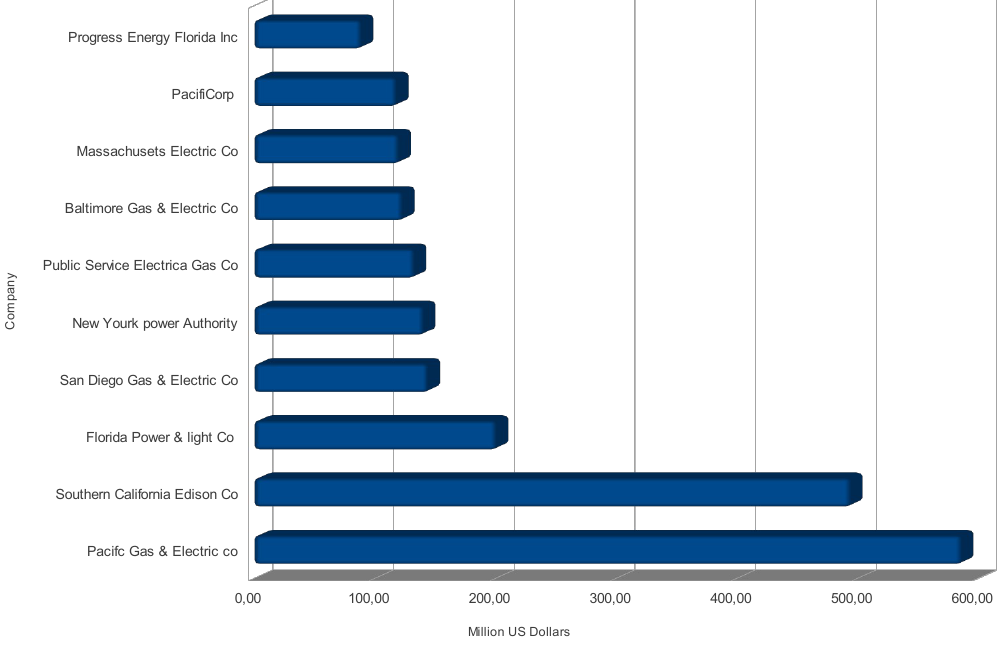
Figure 3. Investments on Demand Side Management (DSM) in the